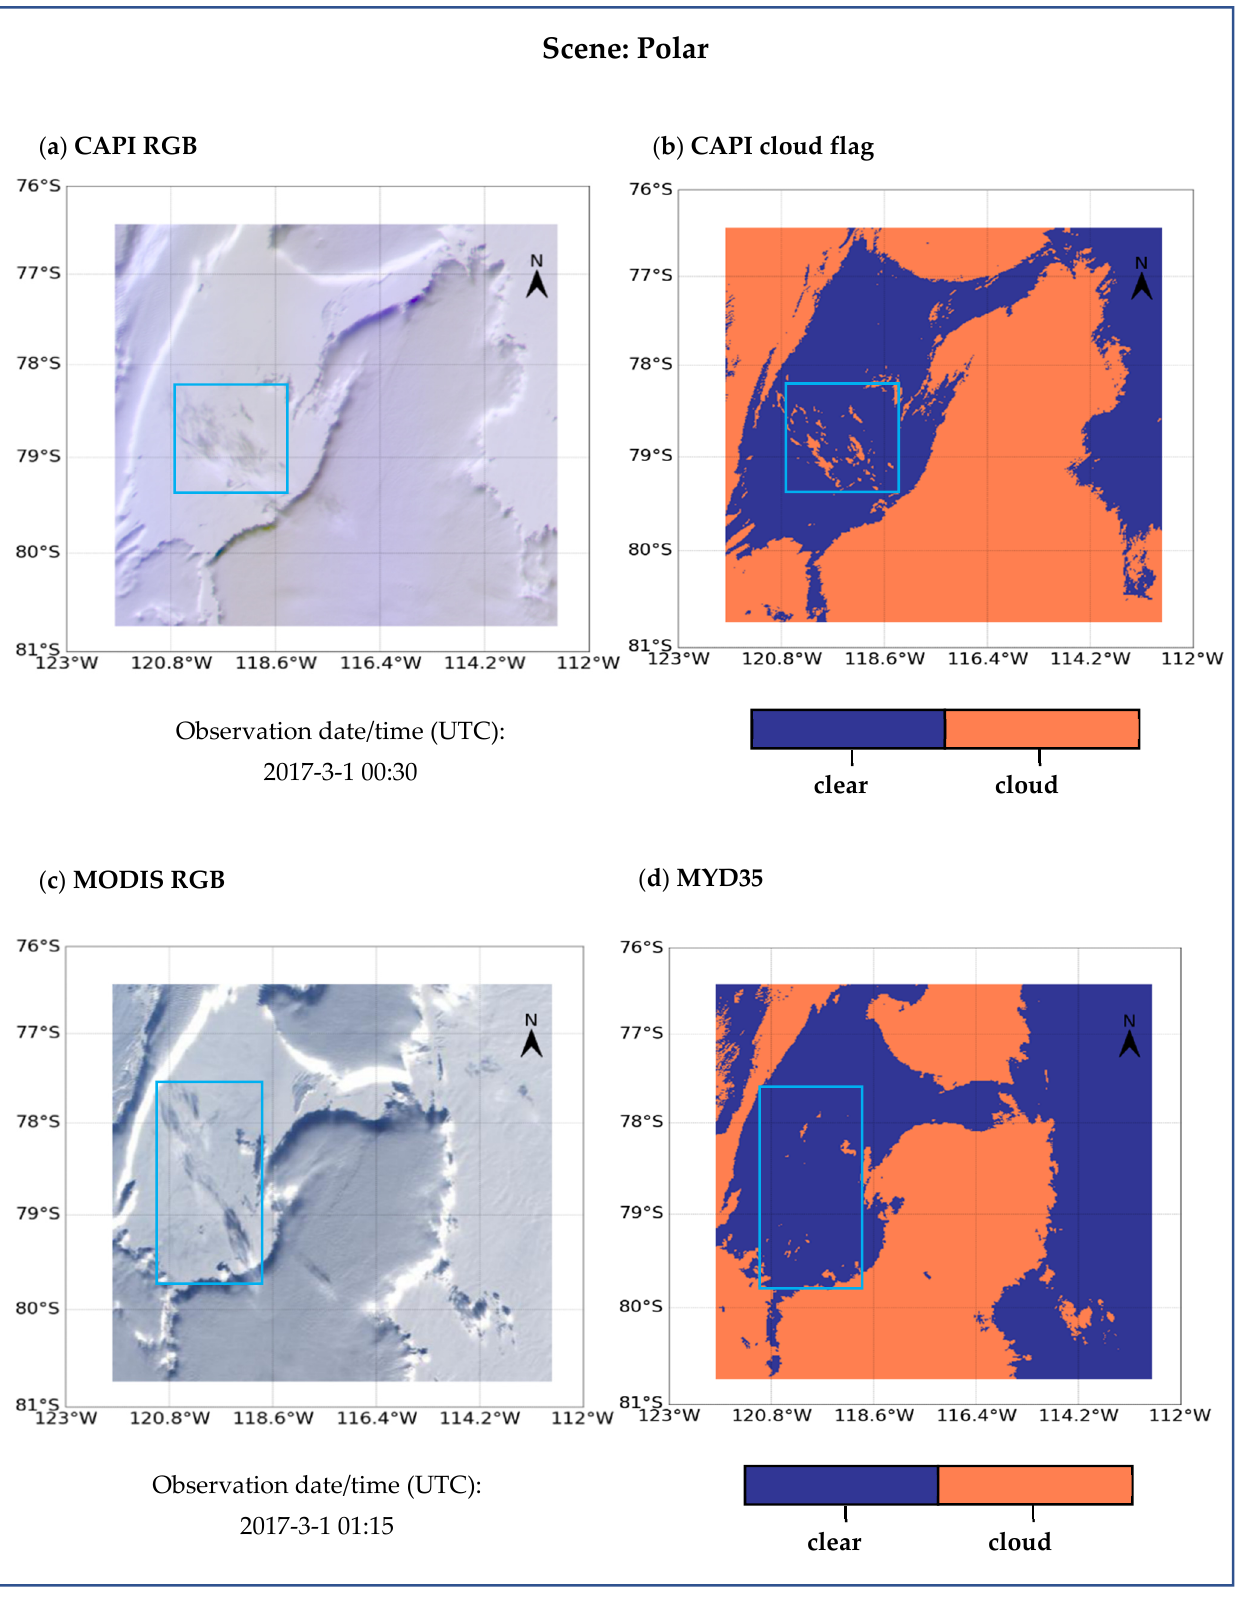
Figure 8. Same as Figure 4, but over the Antarctic continent at 00:30 UTC 1 March 2017 for CAPI and at 01:15 UTC 1 March 2017 for MODIS.